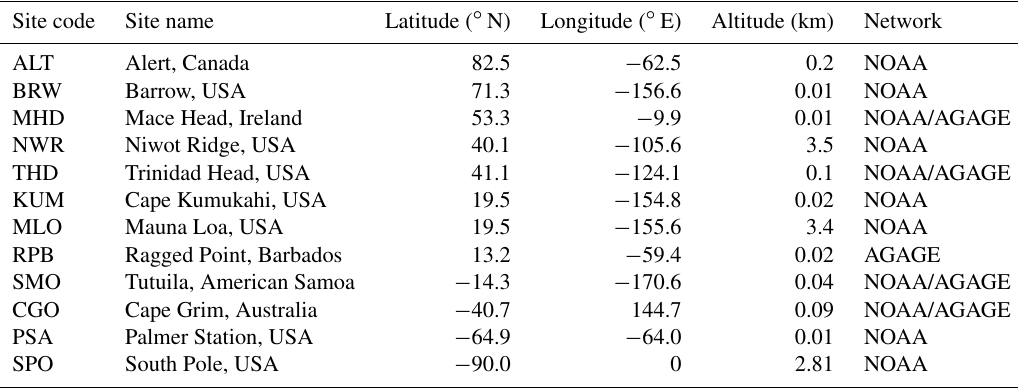
Table 1. List of NOAA and AGAGE stations which provided CCl 4 observations. Site